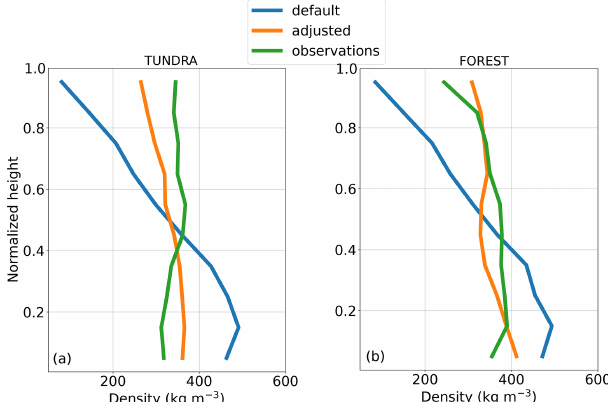
Figure 10. Comparison between observed mean snow density pro- files from Fig. 6 and the simulated density profiles from the default and adjusted versions of Crocus for (a) TUNDRA and (b) FOREST. The modeled mean profiles were obtained by averaging one snow profile per week between the months of January and March for both sites from 2017 to